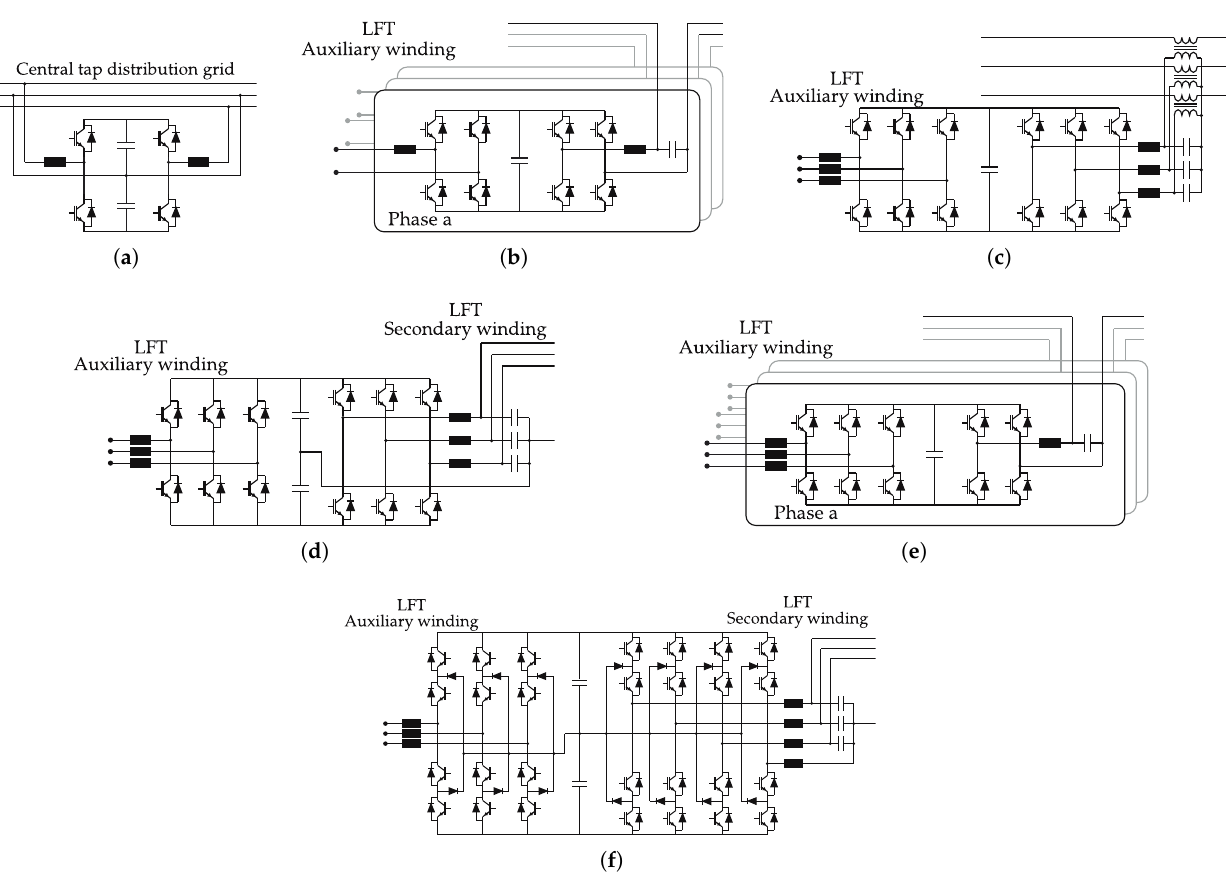
Figure 9. AC/AC converter with intermediate DC-Link stage. ( a ) Back-to-back half-bridge converter. ( b ) Back-to-back H bridge converter. ( c ) Back-to-back three-phase two-level converter. ( d ) Back-to-back three-phase two-level converter for four-wire grids. ( e ) Single-phase representation of a three-phase two-level converter and H-bridge converter in back-to-back configuration. ( f ) Back-to-back neutral pointed clamped (NPC) converter for four-wire